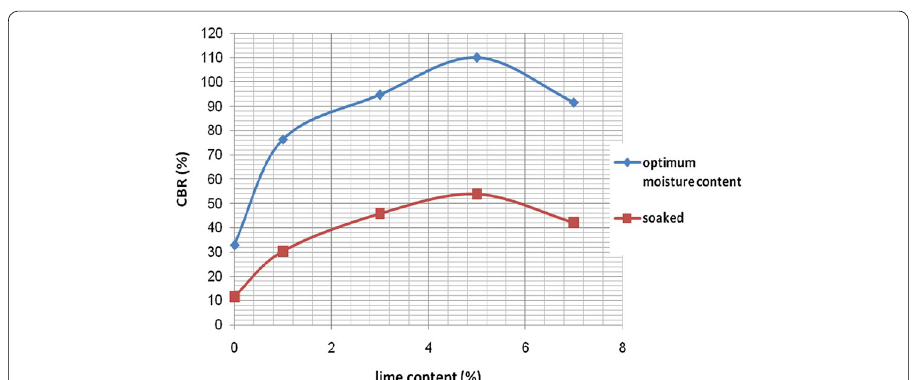
Fig. 8 Effects of lime content on CBR values of samples containing 10%